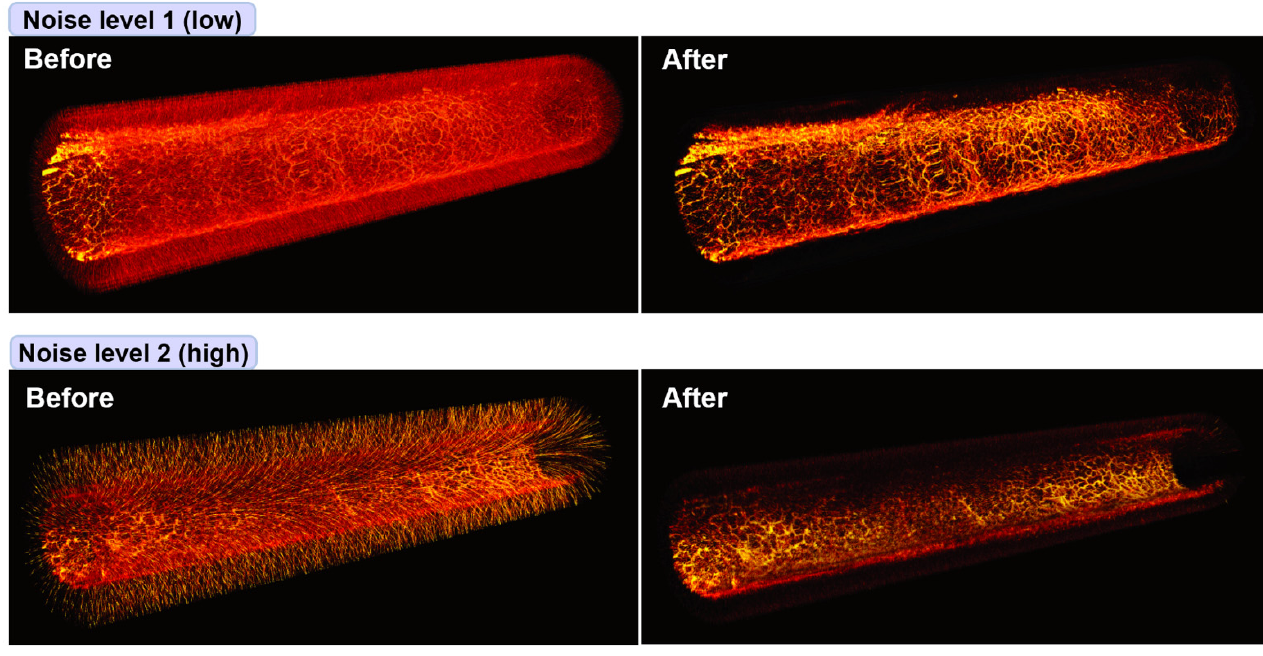
Figure 6. Three ‐ dimensional rendering of the two in vivo rat colorectum test datasets presented in Figure 5. Left and right images correspond to before and after denoising, respectively. Each image corresponds to a range of over ~5 cm with an image diameter of ~7 mm.